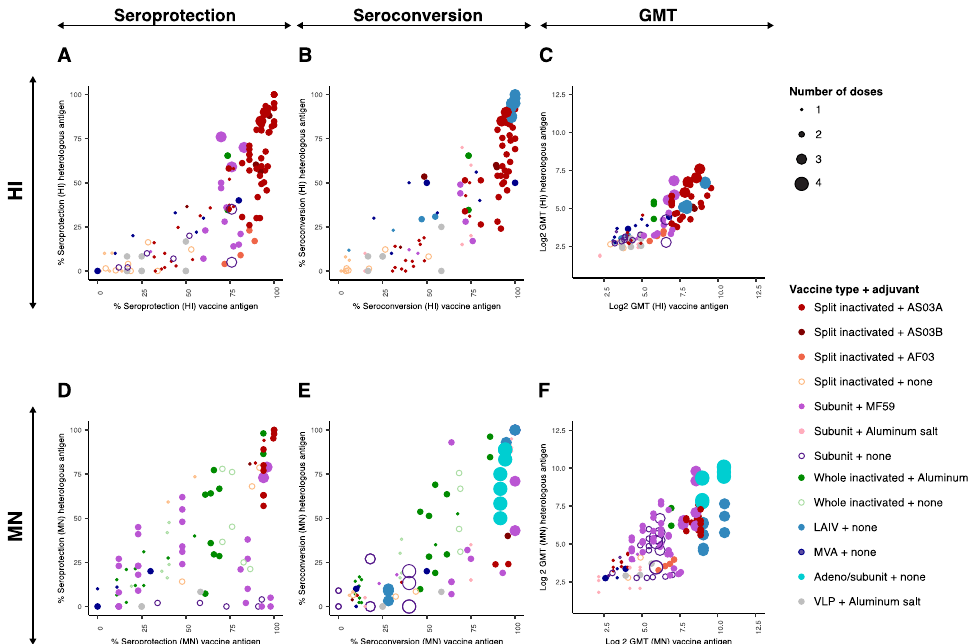
Figure 3. Immunological endpoints upon homologous vaccination regimens. Immunological endpoint values obtained against the homologous antigen (x-axis) are plotted against those obtained against heterologous antigens (y-axis). For clarity, the confidence intervals were not displayed. The color and fill of the individual points indicate the vaccine type and adjuvant combination according to the legend. The size of the circles indicates the number of vaccine doses (one to four) used before the serum sample was obtained according to the legend. ( A ) Percentage of seroprotected subjects measured by HI assay; ( B ) percentage of seroconverted subjects measured by HI assay; ( C ) Log2 of the geometric mean HI titer; ( D ) percentage of seroprotected subjects measured by MN assay; ( E ) percentage of seroconverted subjects measured by MN assay, ( F ) Log2 geometric of the mean MN titer. Abbreviations: HI: hemagglutination inhibition; MN: microneutralization; GMT: geometric mean titer; LAIV: live attenuated influenza vaccine; MVA: modified vaccinia virus Ankara; VLP: virus-like particle.